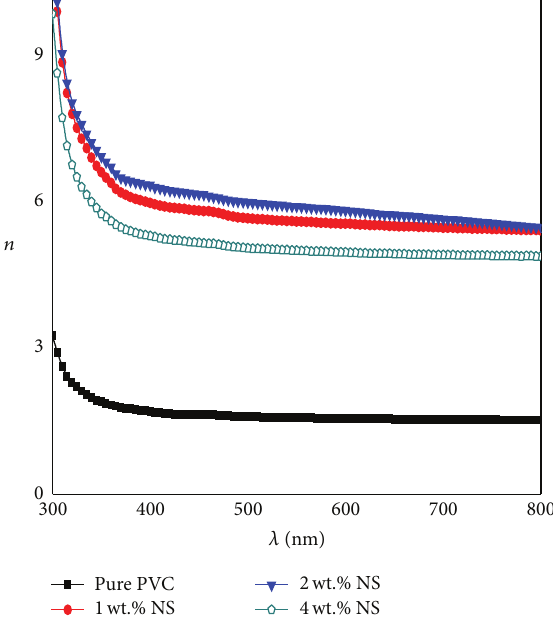
Figure7:Therefractiveindex( 𝑛 )curveforpurePVCandPVC-SiO 2 nanocomposite